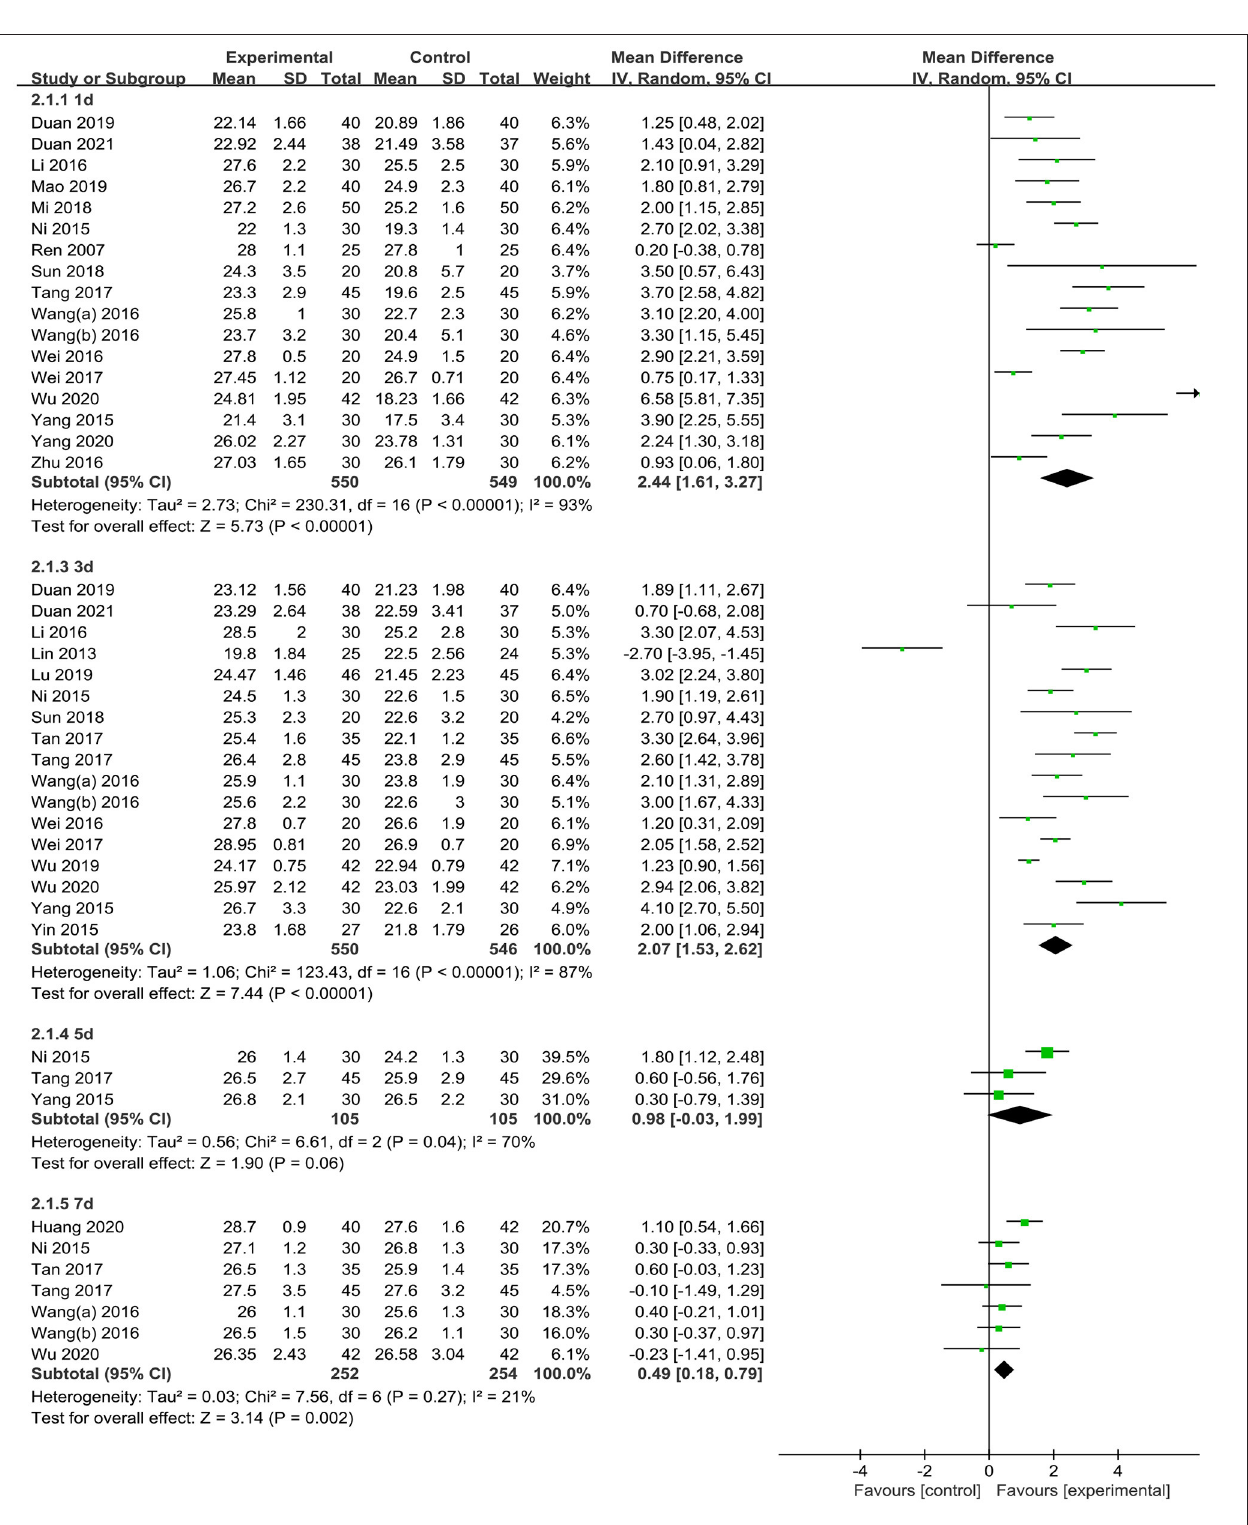
Frontiers in Medicine |